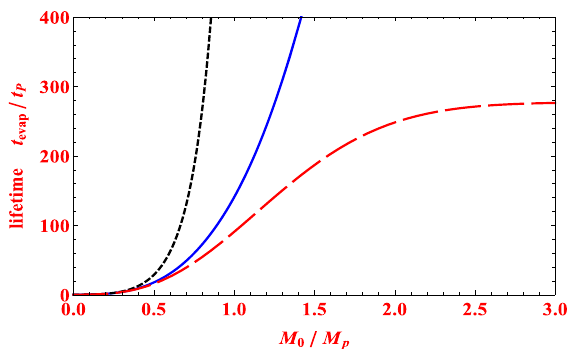
Fig. 6 The scaled life time of BH against black-body radiation in the Tsallis-statistic ( q > 1, red-dashed and q < 1, black-dotted) and in the Boltzmann-statistic ( q = 1, blue-continuous) as functions of the initial masse of